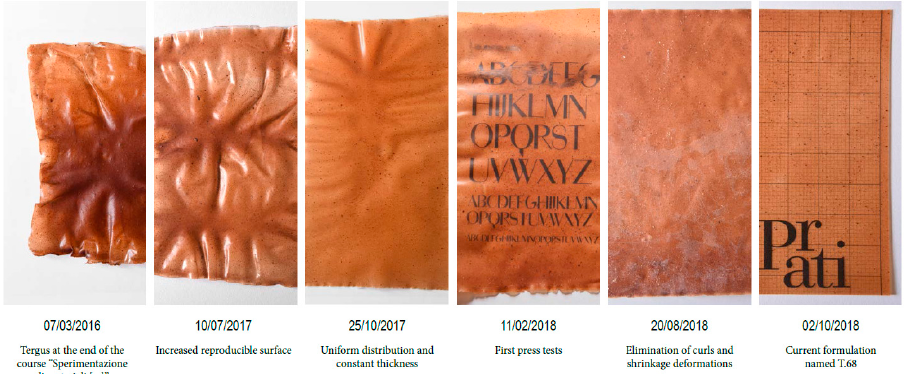
Table 1. Different components of the film.